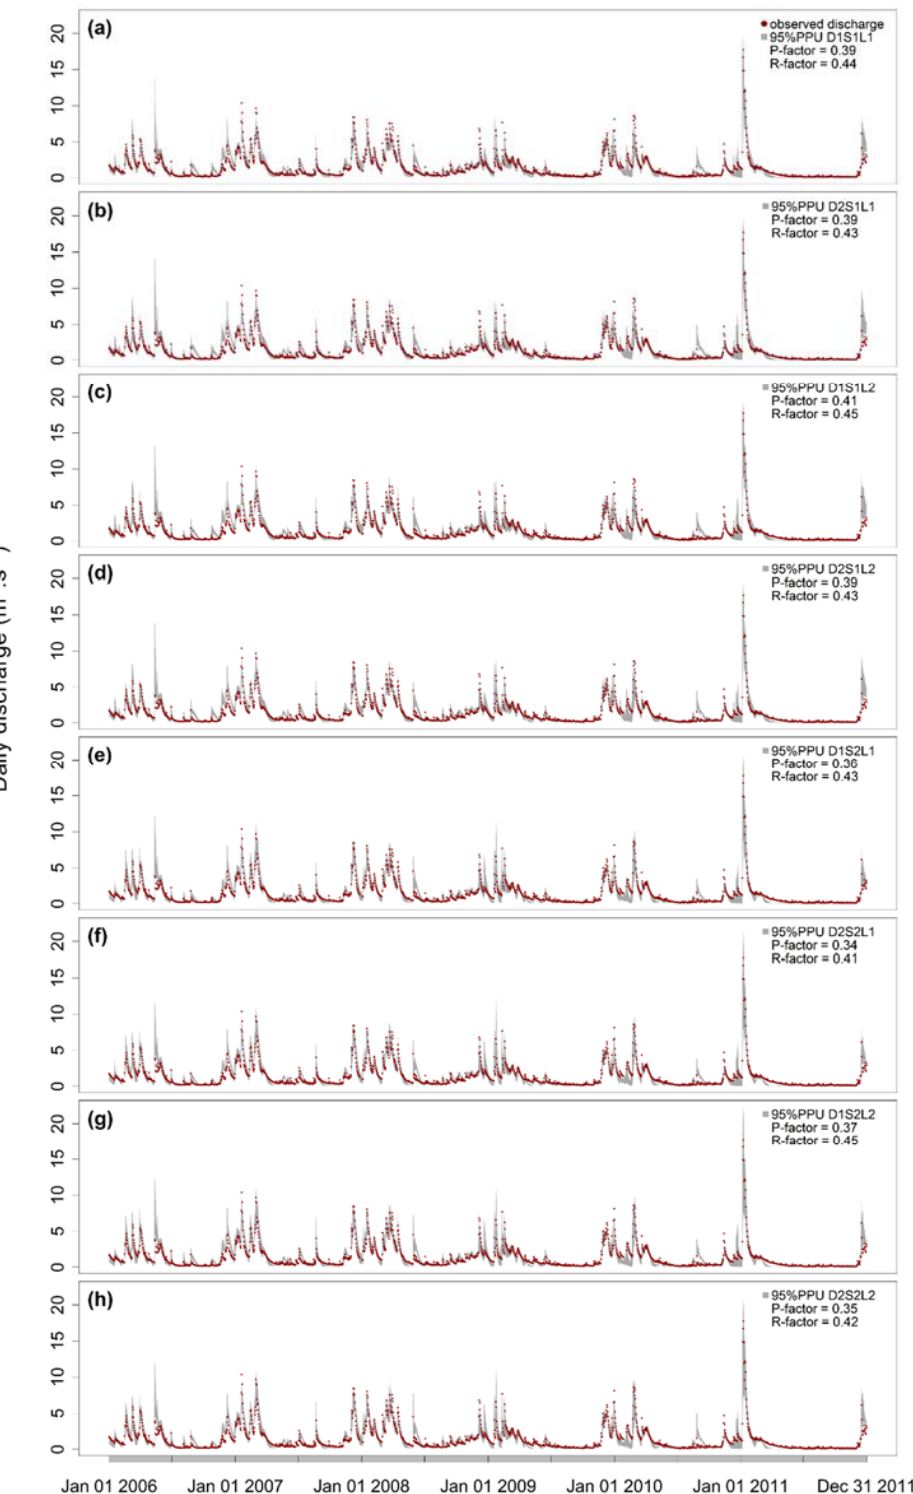
Figure 4. Hydrographs comparing all setups ( a – h ), including the 95% prediction uncertainty and the P ‐ and R ‐ factors.